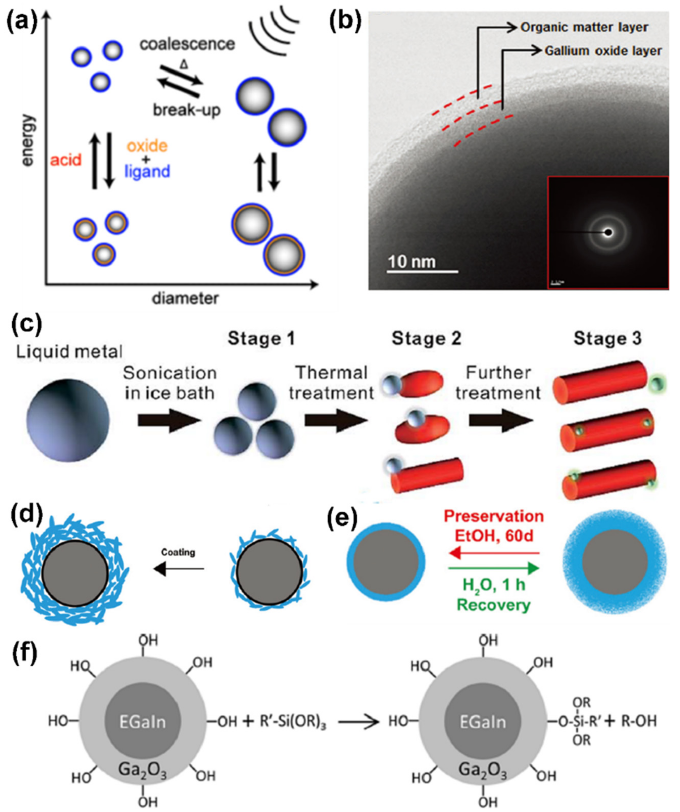
Figure 4. Liquid metal–ligand molecule composites. ( a ) Reversible size control of LM nanoparticles under ultrasonication. Reprinted with permission from Ref. [57] Copyright 2015 John Wiley and Sons. ( b ) HRTEM image of the bilayer of LM shell. Reprinted with permission from Ref. [58] Copyright 2016 John Wiley and Sons. ( c ) Illustration of the shape transform process under aqueous solu- tion. Reprinted with permission from Ref. [60] Copyright 2017 Royal Society of Chemistry. ( d ) Scheme of degraded PVP molecules adsorbed onto the oxidized surface of LM nanoparticles. ( e ) Schematic illustration of the preservation recovery mechanism of LM–PVP nano-composites. Re- printed with permission from Ref. [61] Copyright 2020 Royal Society of Chemistry. ( f ) Scheme de- picting the reaction of LM particles possessing hydroxylated gallium oxide shells. Reprinted with permission from Ref. [67] Copyright 2020 American Chemical Society.